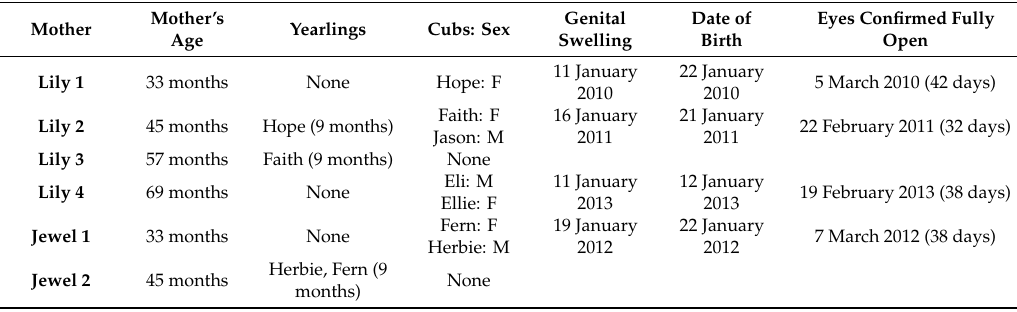
Table 2. Mother and o ff spring demographic and developmental data for the six litters of black bears observed in their dens in